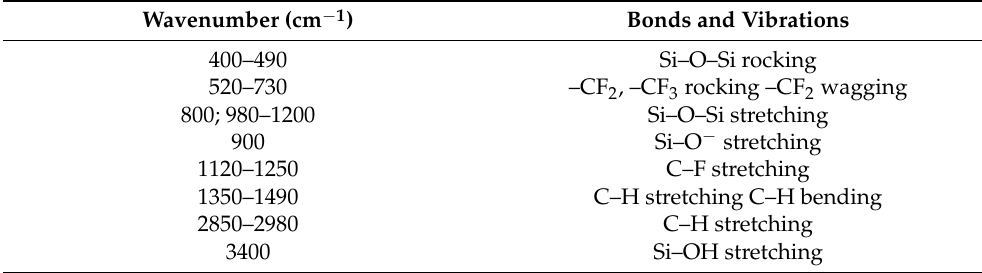
Table 1. Main bands or band range with corresponding bond vibration in FTIR spectra.